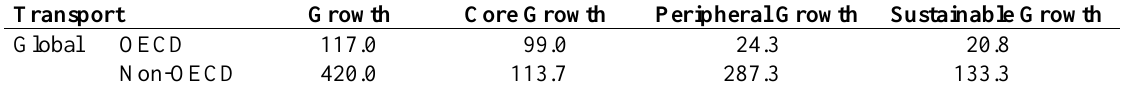
Table 11. Absolute growth in volume of the transport sector (in %) Transport Growth Core Growth Global